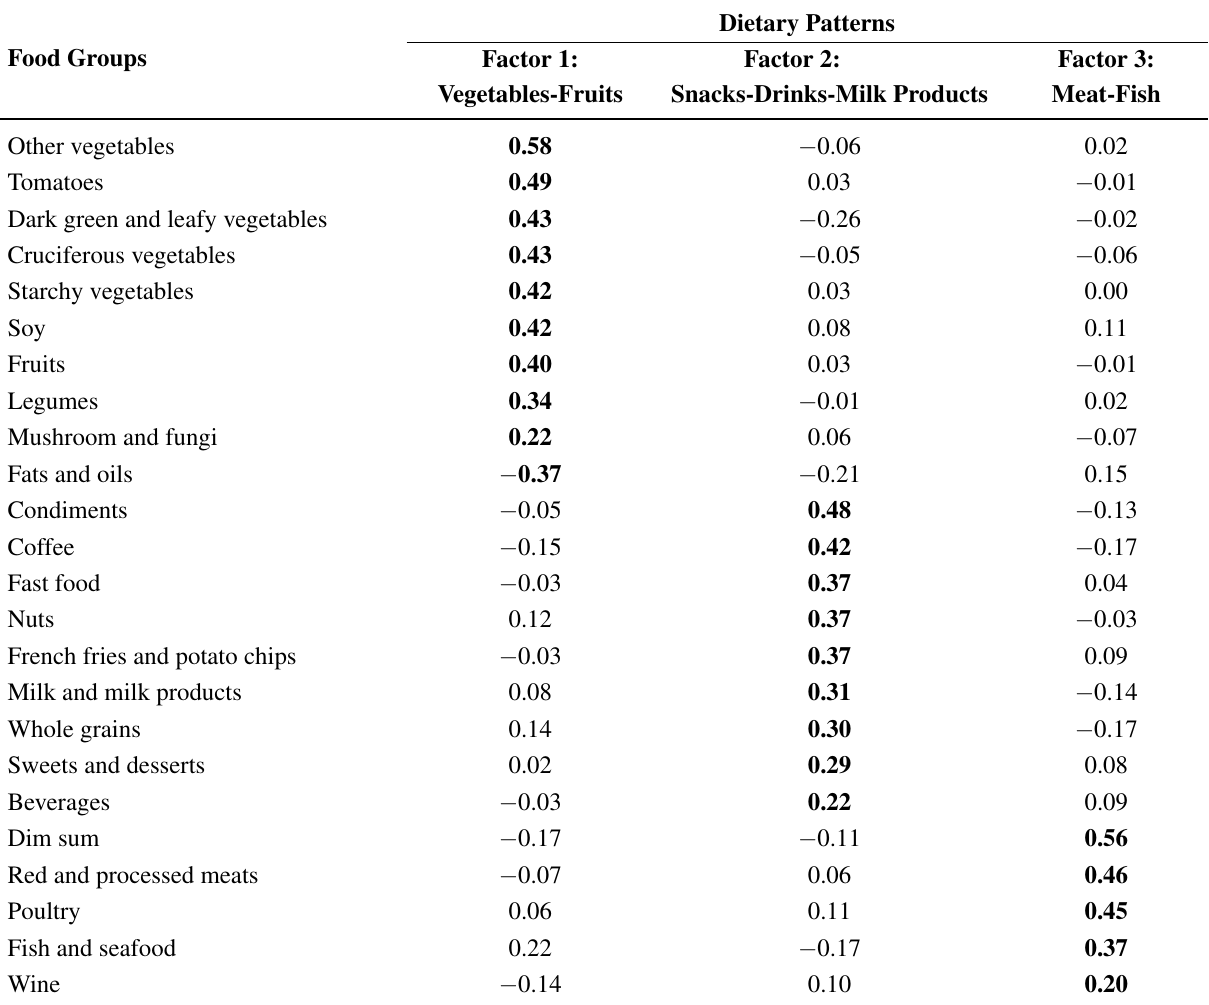
Table 1. Food group factor loading a for three dietary